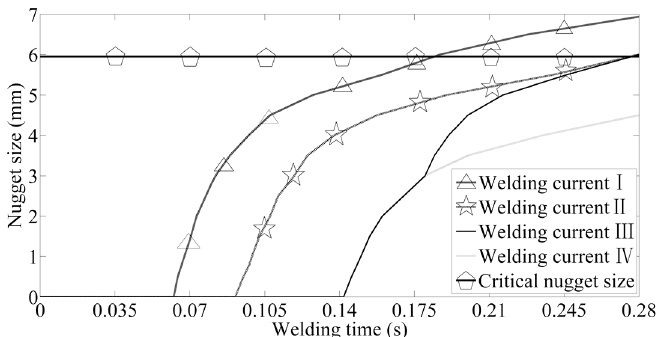
Figure 18. Controlling the nugget size.